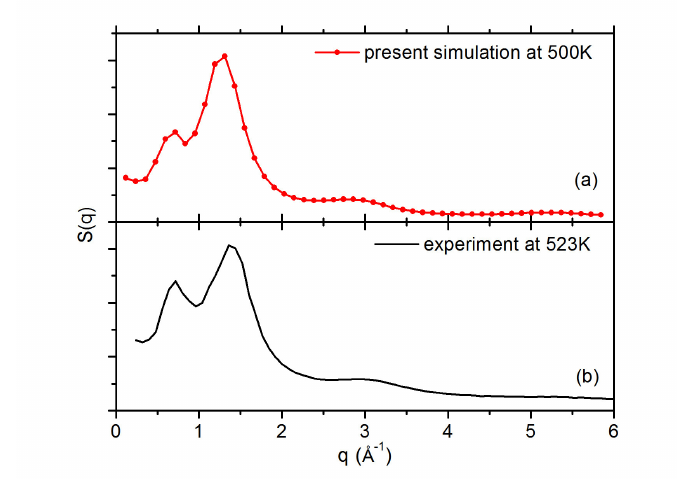
Figure 1. The static structure factors S( q ) of PS melt ( a ) calculated from simulation at 500K; and ( b ) from experimental X-ray diffraction reported in Ref. [60] at 523 K. Data in ( b ) are reprinted from Ref. [60] with permission from